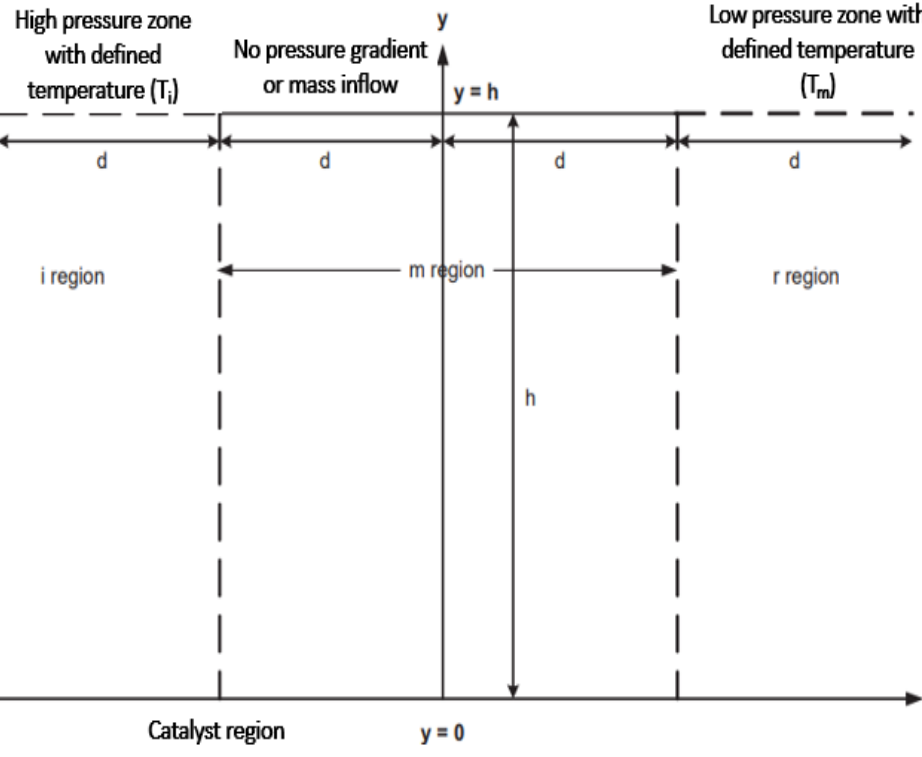
Figure 2. A simplified geometry highlighting the division of the modelled GDL (adapted from [25]).